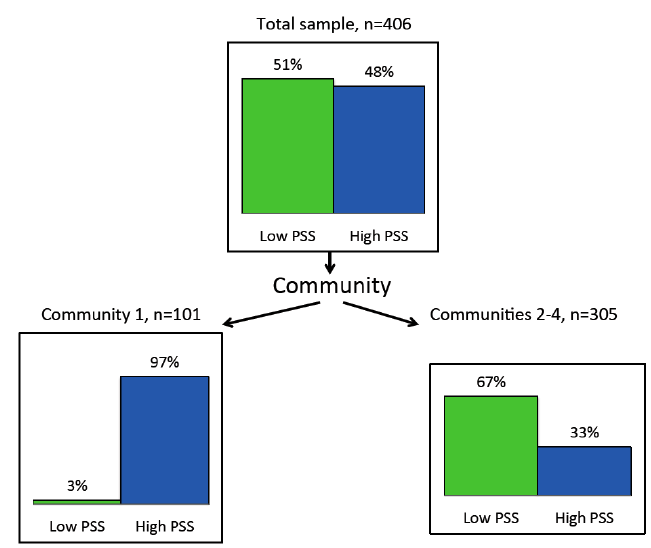
Figure 7. CHAID segmentation of sample by stress (PSS). Table 2. Summary table showing predictors of perceived stress (PSS) by Community, based on CCR Logistic regression models and chi-squared tests of significance.